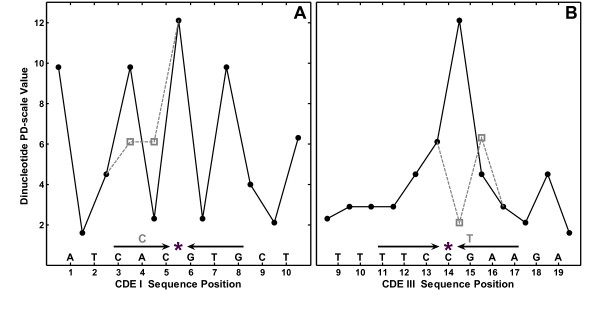
PD-scale profiles of native CDEI & CDEIII compared with single mutant examples. PD magnitude profiles of the positions in the core binding sites of wild type CDEI and CDEIII, shown as filled circles. The 2 PD values altered by a single selected base mutant in both core binding areas are shown as squares with the mutant base placed above the corresponding base in the wild type sequence.